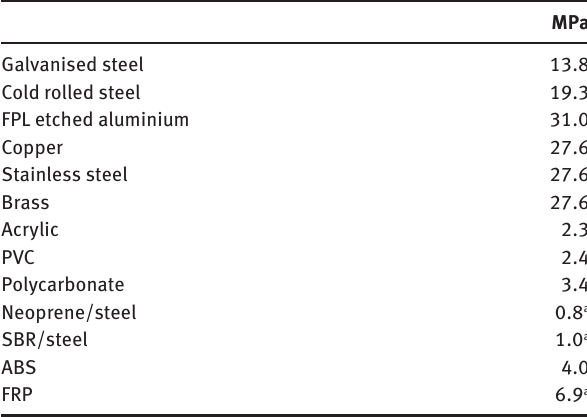
Table 2: Overlap shear strength of DP-460 epoxy adhesive